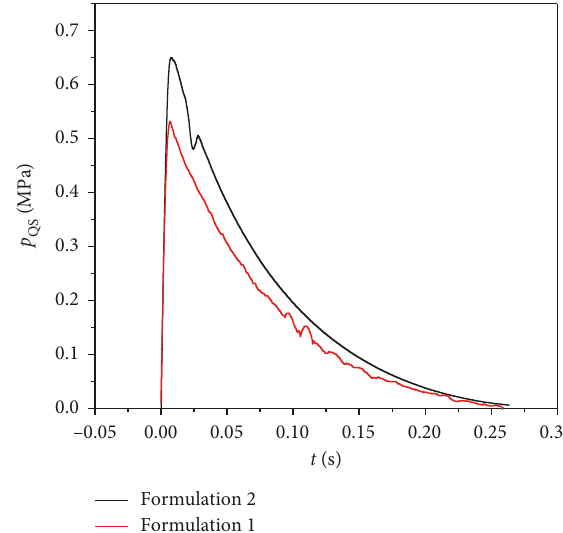
Figure 7: Pressure-time curve of the quasistatic